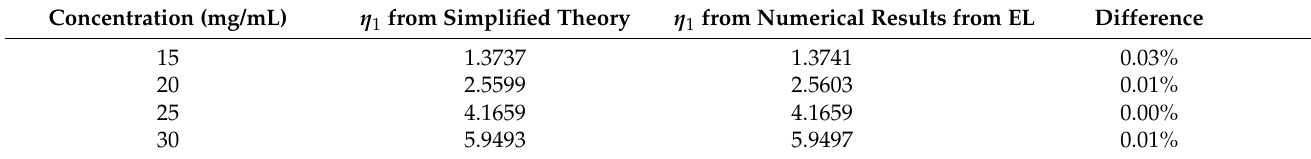
Table 4. Comparison of dimensionless theoretical values of η 1 and calculated from the EL at different concentrations.